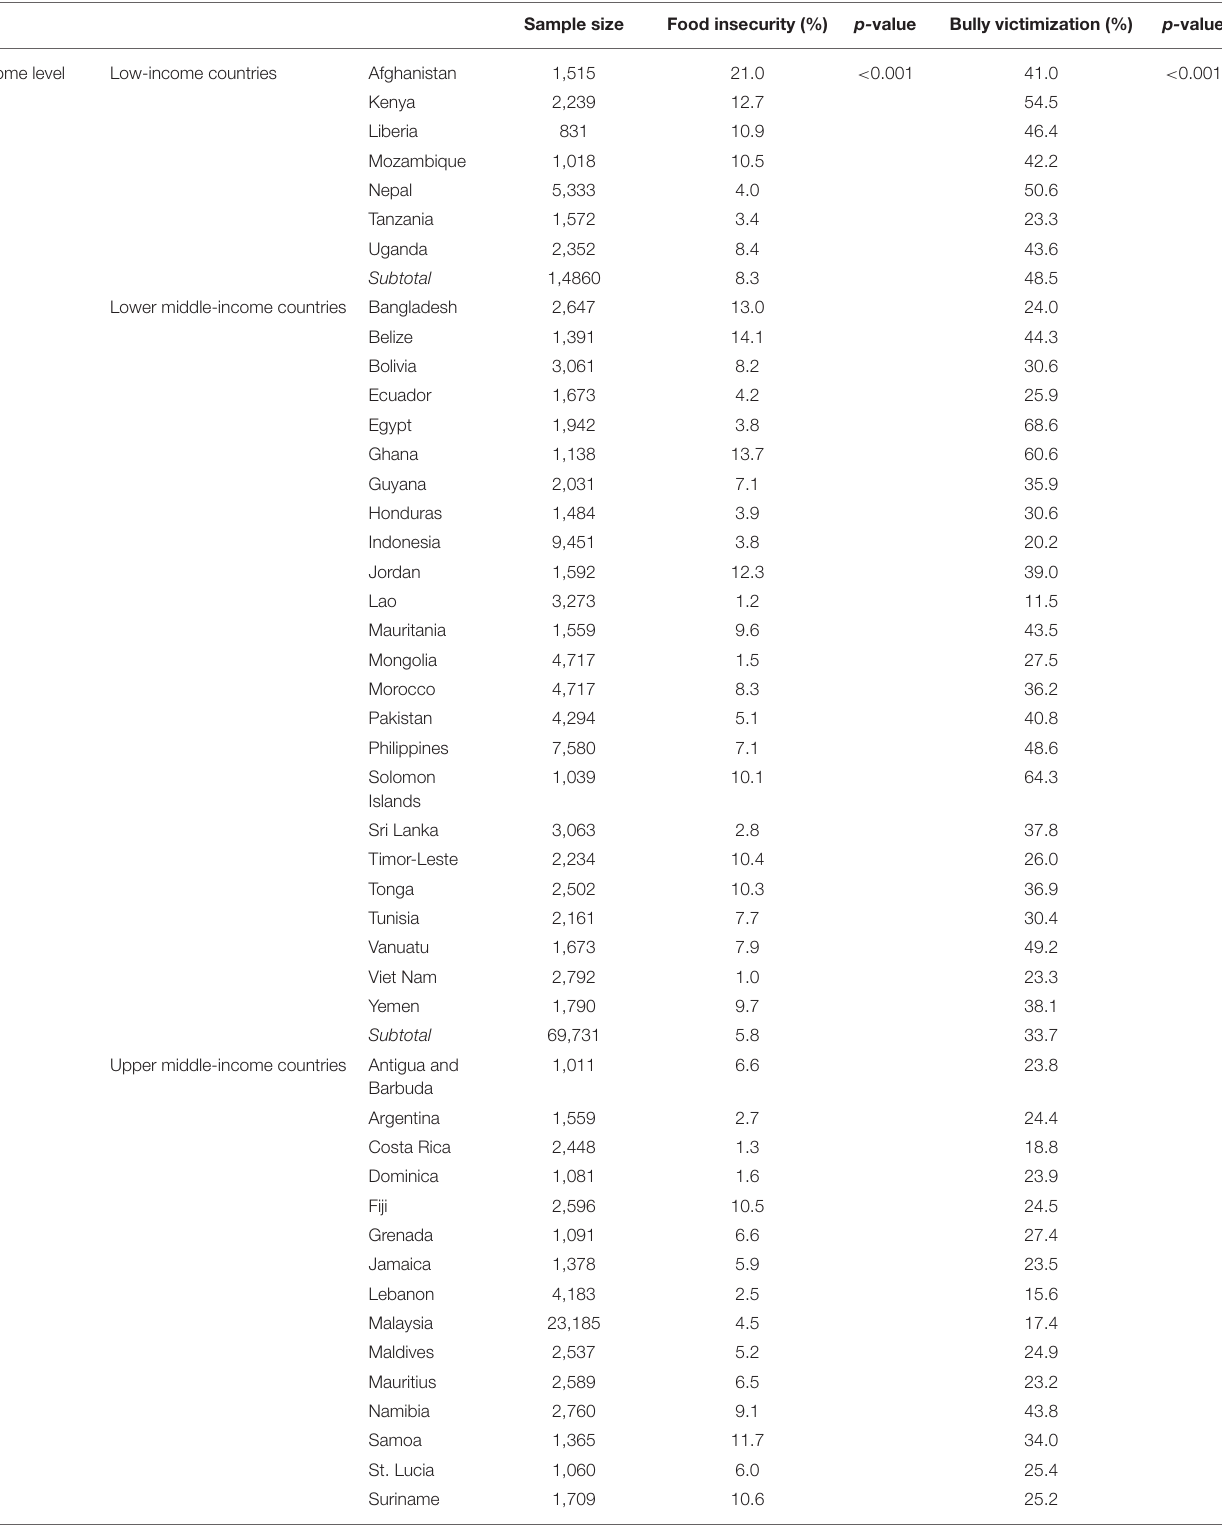
TABLE 1 | Prevalence of food insecurity and bullying victimization by countries, sexes, and age groups. Sample size Food insecurity (%) p- value Bully victimization (%) p-